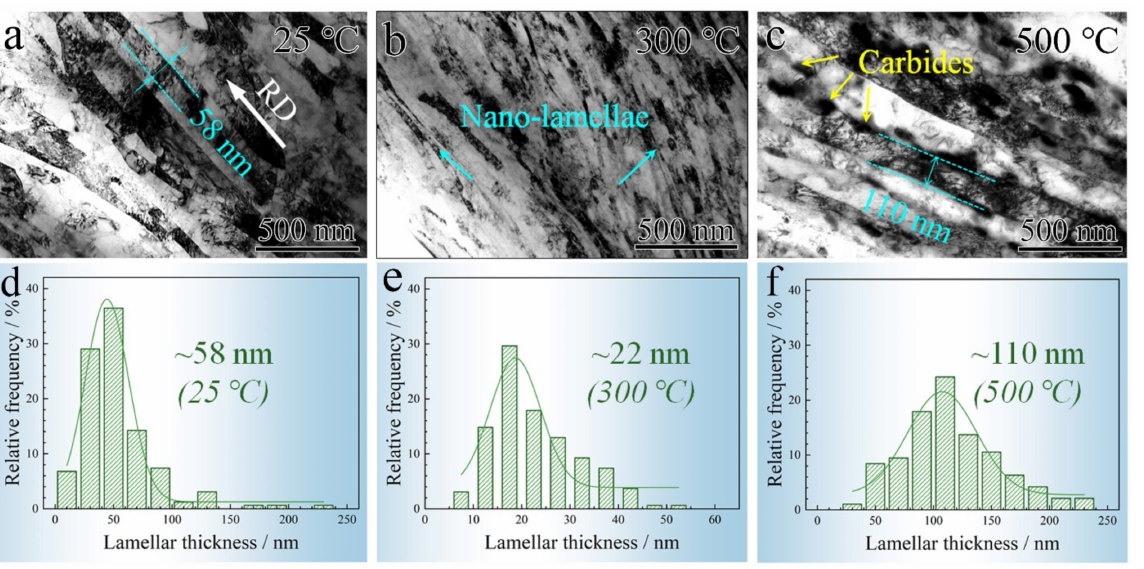
Figure 3. Bright-field TEM micrographs of the dual-phase steels rolled at ( a ) 25 ◦ C, ( b ) 300 ◦ C, ( c ) 500 ◦ C, ( d – f ) distribution of lamellar thickness for samples rolled at 25 ◦ C, 300 ◦ C, and 500 ◦ C,